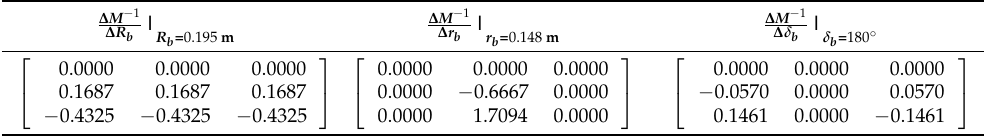
Table 2. Sensitivity of M − 1 to the values of the nominal kinematic parameters of the wheel b .